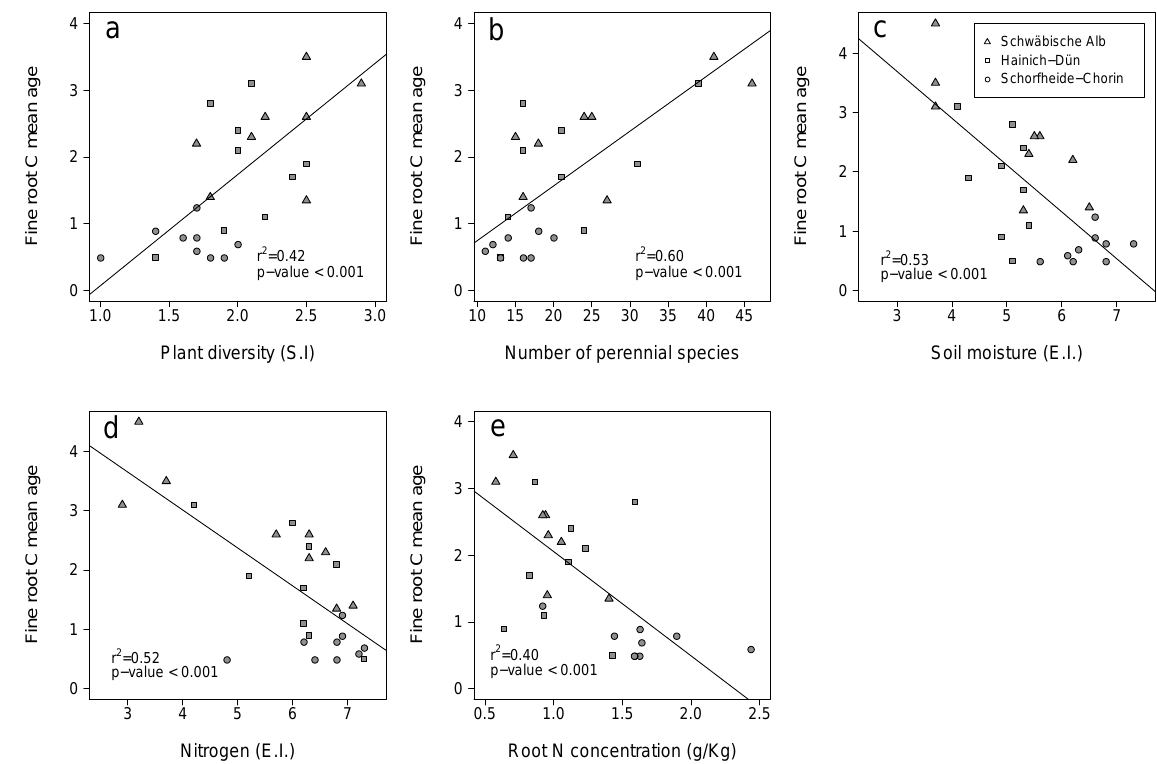
Fig. 3. Relationships between the mean age of fine roots and (a) plant diversity, (b) total number of perennial species, (c) Ellenberg indicator for moisture, (d) Ellenberg indicator for nitrogen, and (e) fine root nitrogen concentration in the grasslands ( n = 27). Table 5. Pearson’s correlation matrix between variables in grasslands. Numbers in bold indicate a significant correlation ( p < 0.05). E.I. = Ellenberg indicator values, S.I. = Shannon index ( n = 27).